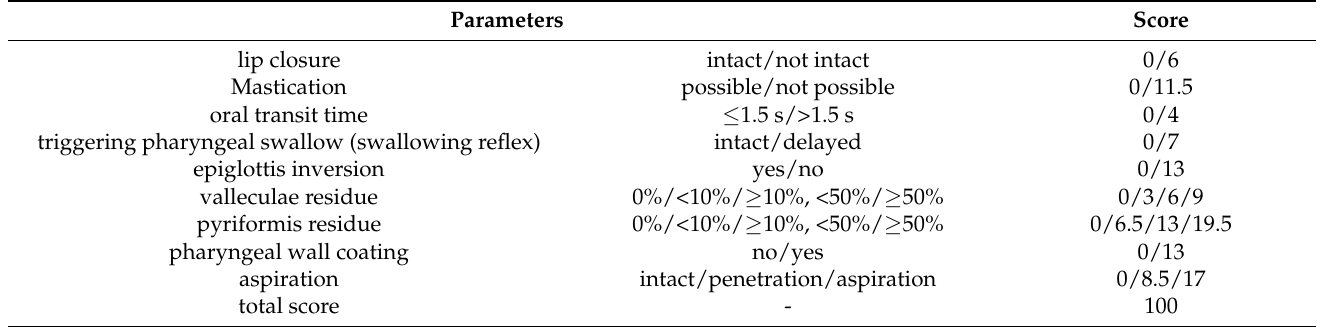
Table 1. Modified version of the Videofluoroscopic Dysphagia Scale.